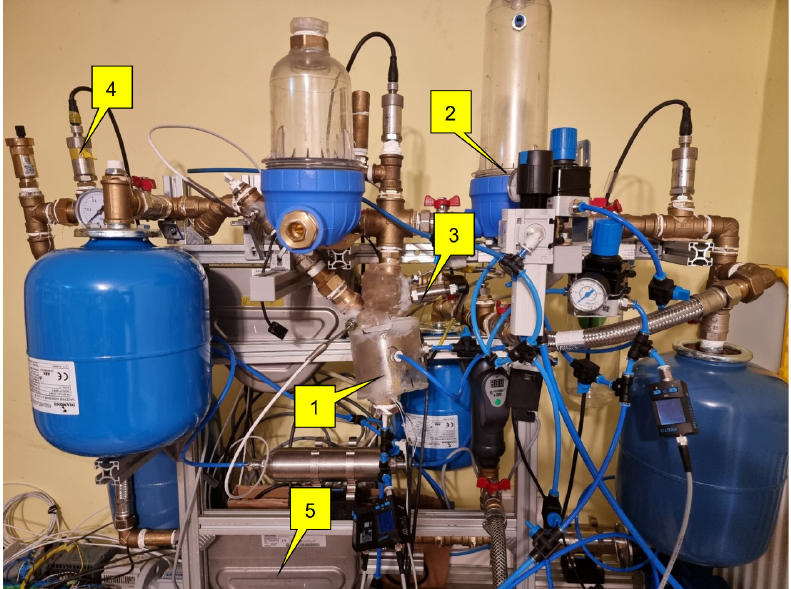
Figure 3. Experimental stand: (1)—flexible left heart model closed in a transparent cylinder, (2)—flow reservoir replacing the pulmonary veins, (3)—atrium pressure sensor, (4)—aorta pressure sensor, (5)—artificial blood flow